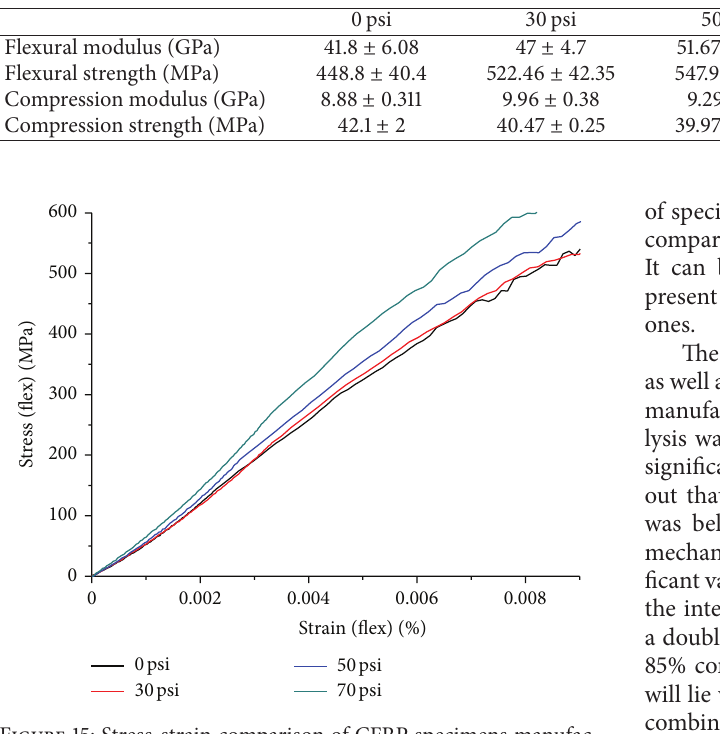
Table 3: Comparison of specimens manufactured in press-clave and autoclave.